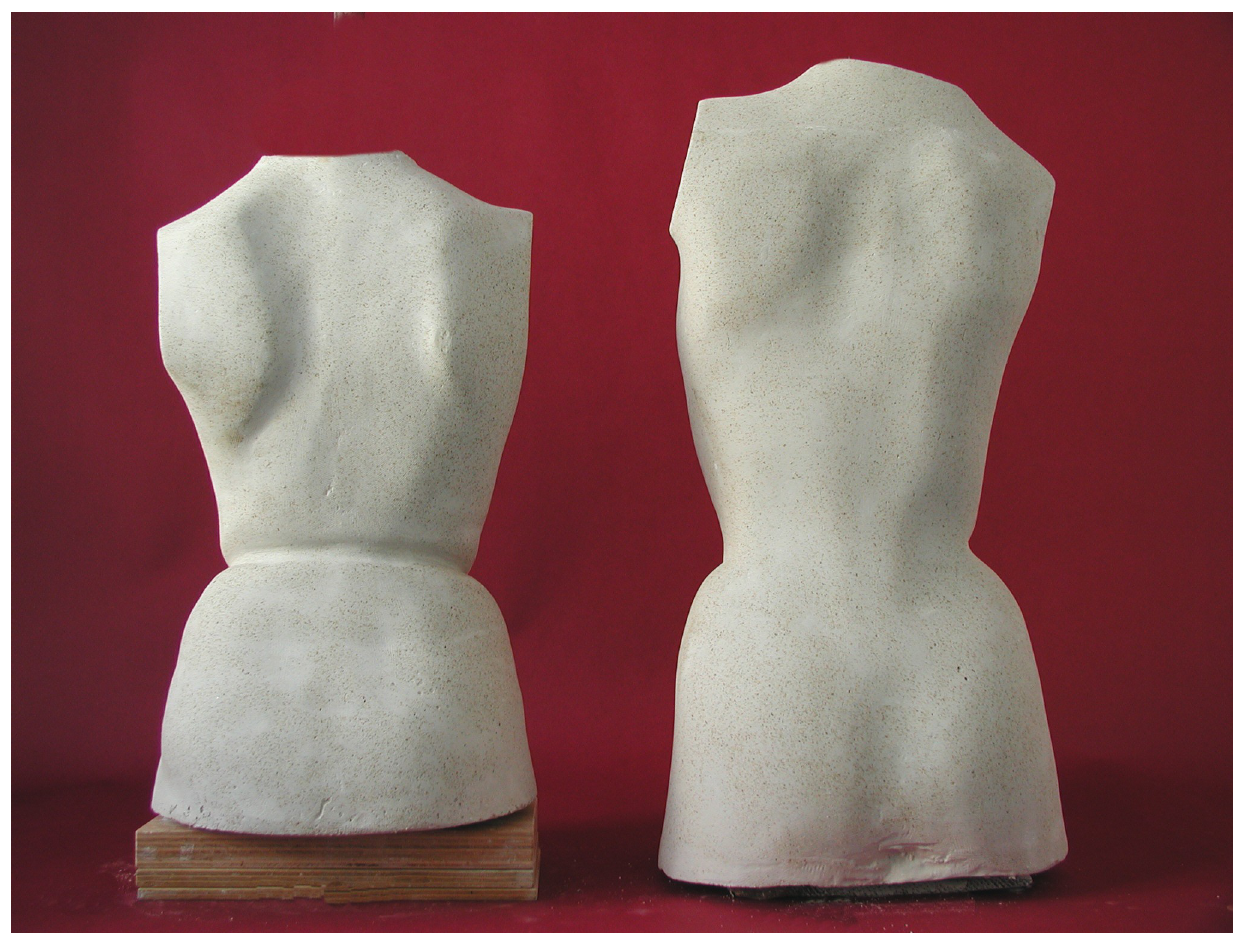
Fig 1. Plaster model of a patient with AIS—standing position (left) and lying position (right)–thus demonstrating the gravity dependent change of trunk